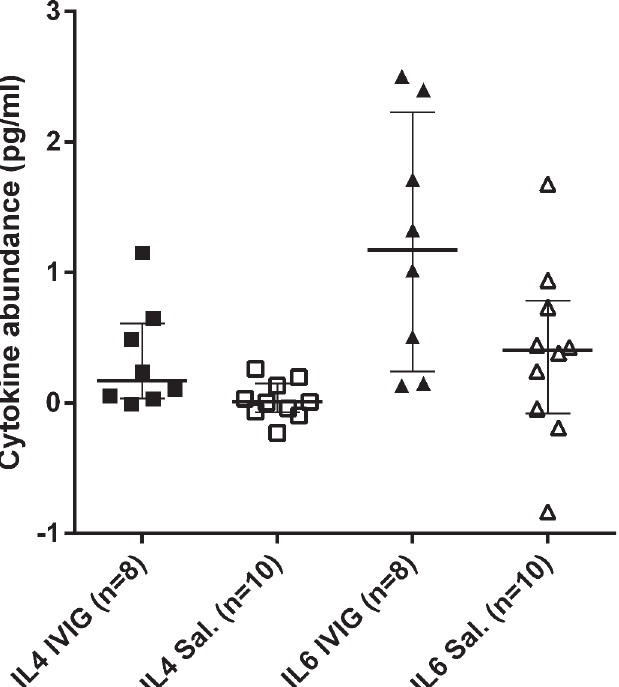
Fig 4. Interleukin (IL)-4 and IL-6 abundance in children with acute encephalitis syndrome receiving intravenous immunoglobulin (IVIG) and placebo. Median and inter-quartile range of change in cytokine abundance (pg/ml) pre and post treatment is presented for IL-4 and IL-6 separately. Cytokine abundance increased for both IL-4 and IL-6. This increase was significant for IL-4 (p = 0.043 and p = 0.068 for IL-4 and IL- 6 respectively). Difference in abundance was assessed via Wilcoxon-Mann-Whitney test. Note: Four patients (three who received IVIG and one who received saline) were not included in this analysis because of insufficient sample to undertake the